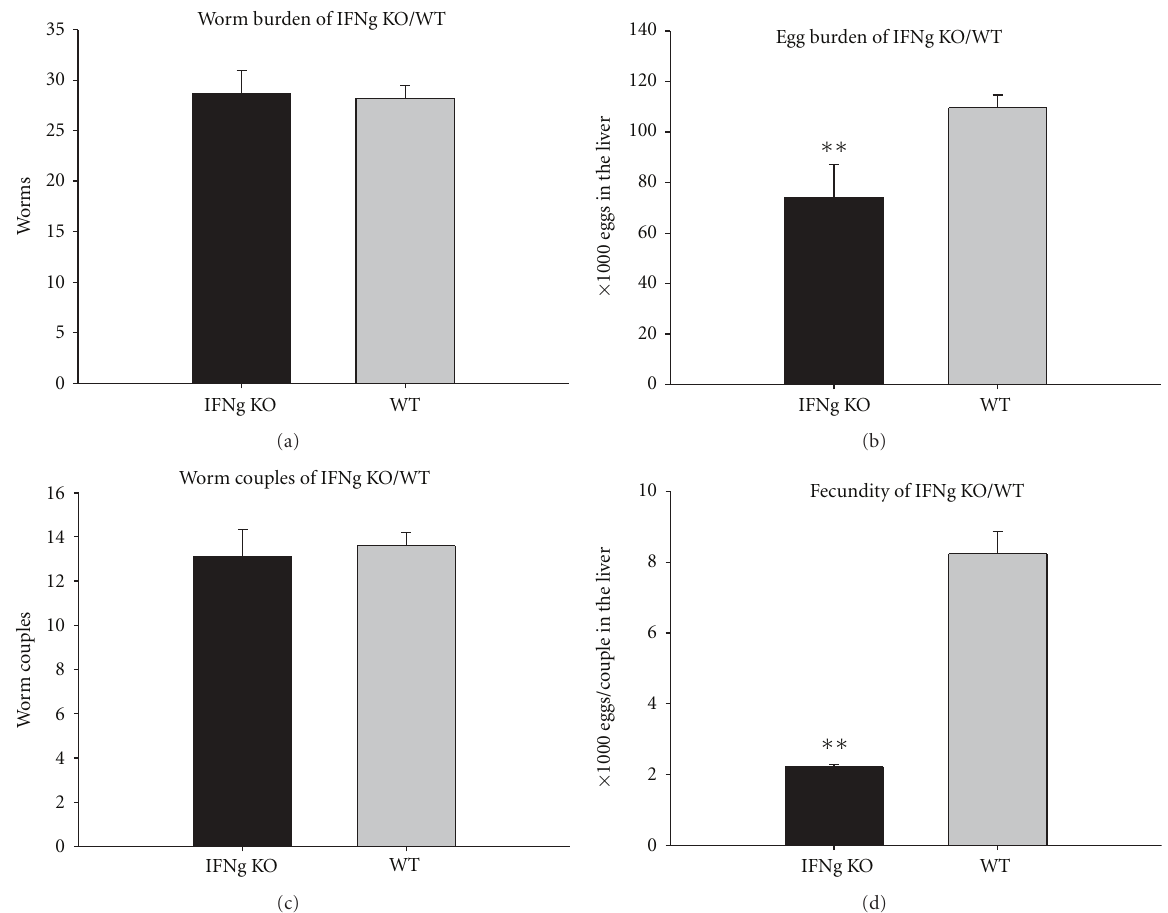
Figure 1: Parasite burden of IFNg KO mice and WT mice ( n = 10, resp.) at 6 weeks after-infection with Schistosoma japonicum (compared with WT mice, ∗∗ P < 0 . 01). (a) Total worms were recovered by portal perfusion at 6 weeks after-infection. (b) Eggs deposited in the liver were counted after digestion of the liver with 5% KOH. (c) Worm pairs were recovered by portal perfusion at 6 weeks after-infection. (d) Eggs deposited per worm couple in the liver. Data are representative of two independent experiments with the similar